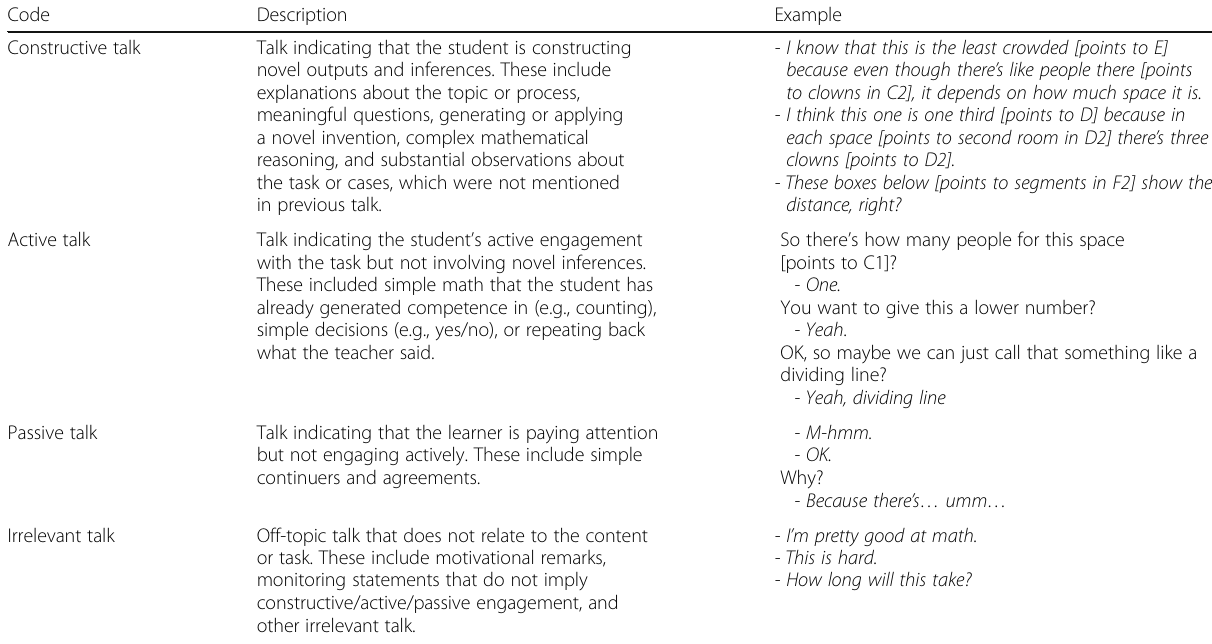
Table 2 Student talk codes. Student statements are italicized, while teacher statements are not